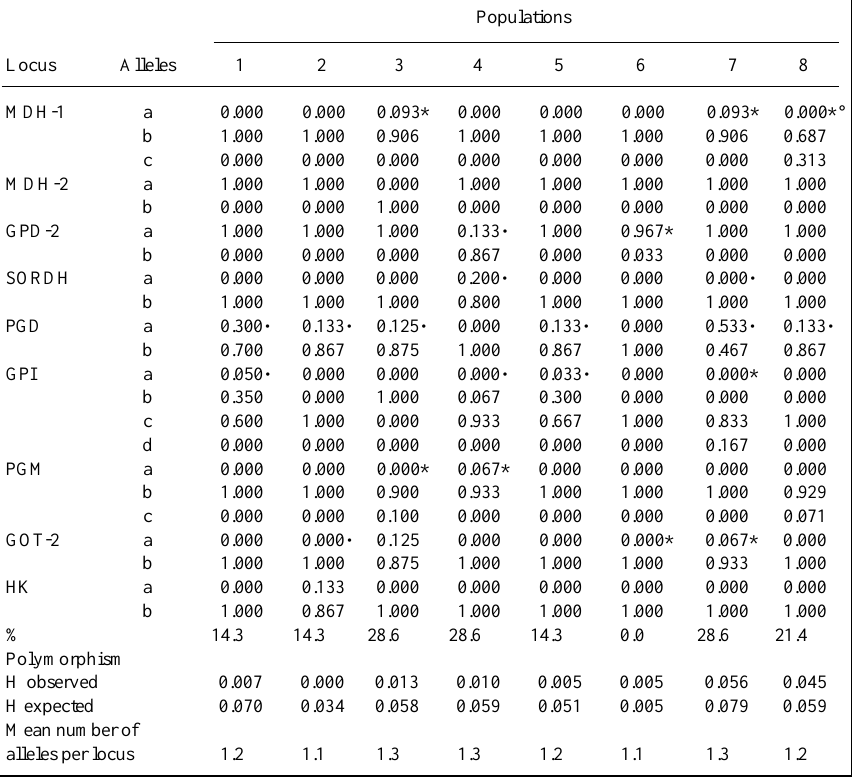
Table I - Allelic frequencies, polymorphism (%), heterozygosity (observed and expected), and mean number of alleles per locus at nine variable loci for eight populations of Batrachyla leptopus .